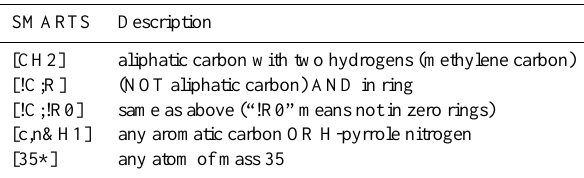
Table 2. Generic SMARTS strings taken from the daylight informa- tion web